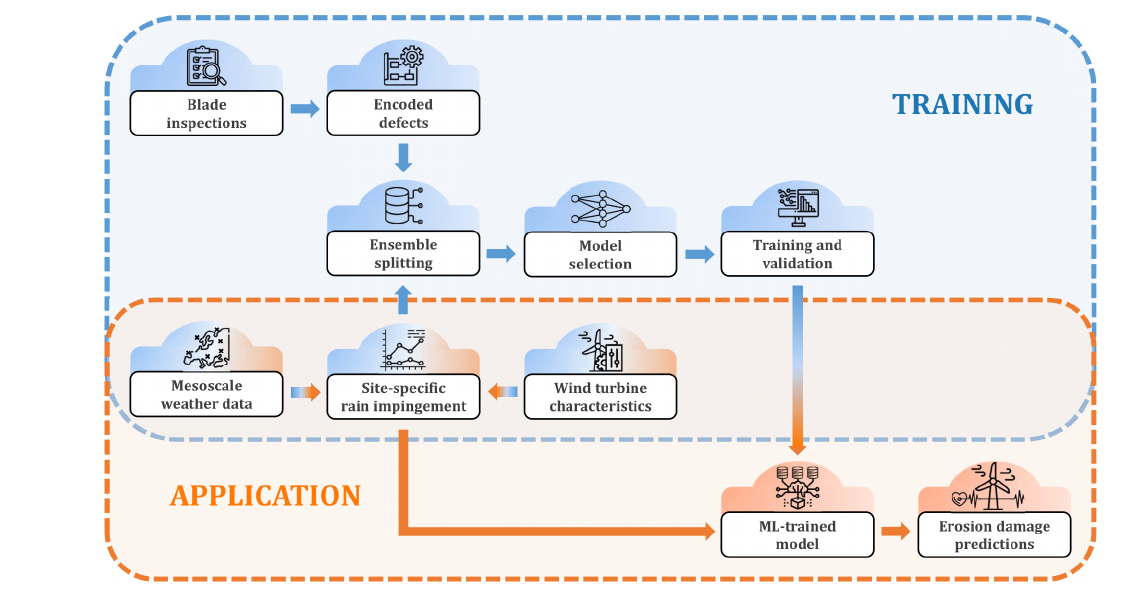
Figure 1. High-level workflow visualizing the main steps of the modeling framework and the distinction of training and application flows.